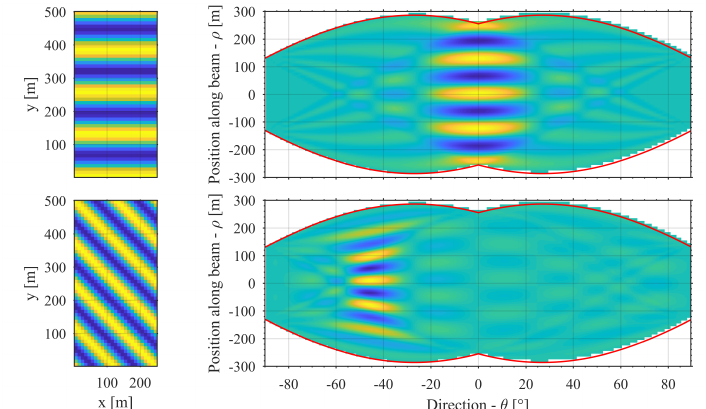
Figure 2. Radon transform sinograms for the synthetic datasets containing (1) a shore normal wave (0 degrees) and (2) an oblique example where k x = k y . The red lines indicate the sinograms limits along the beam